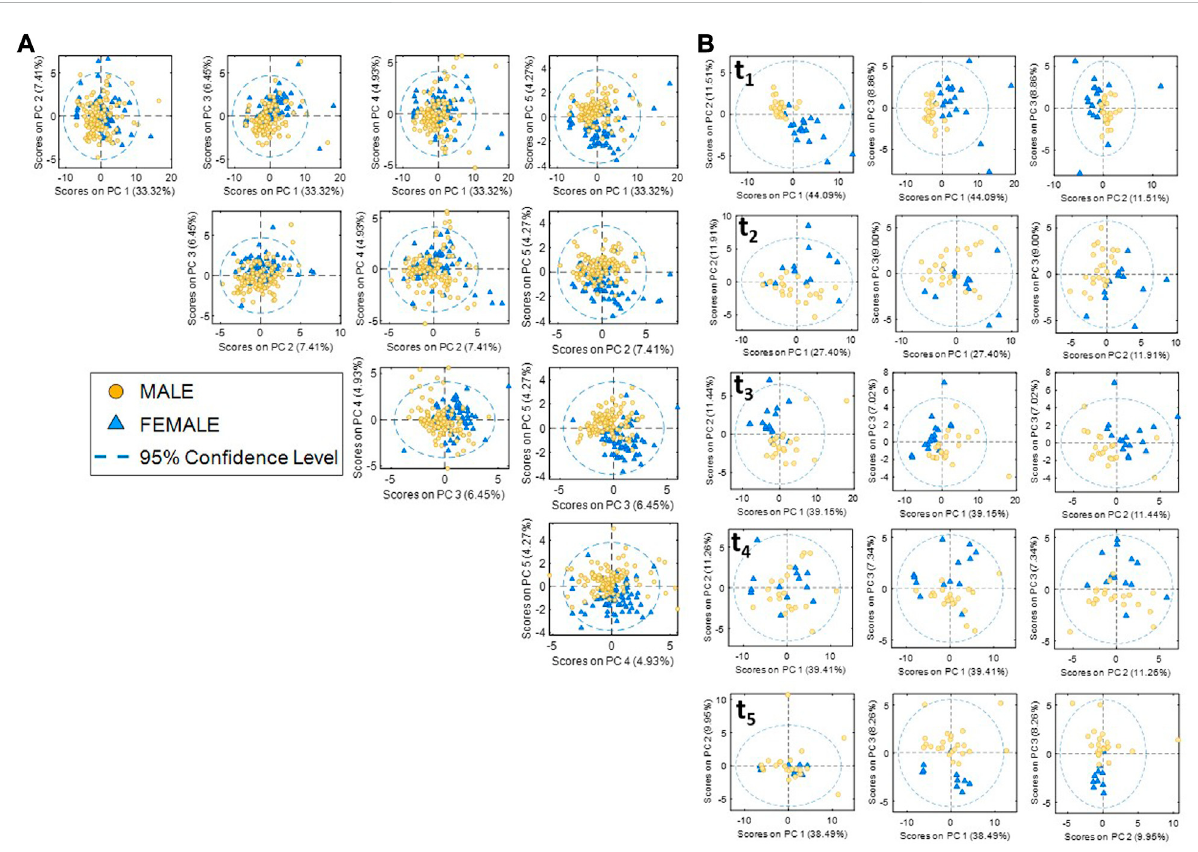
FIGURE 2 Principal component analysis (PCA) of metabolomic data. (A) Scores plots of metabolomic data (male and female data sets). (B) Scores plots of metabolic data at each sample collection